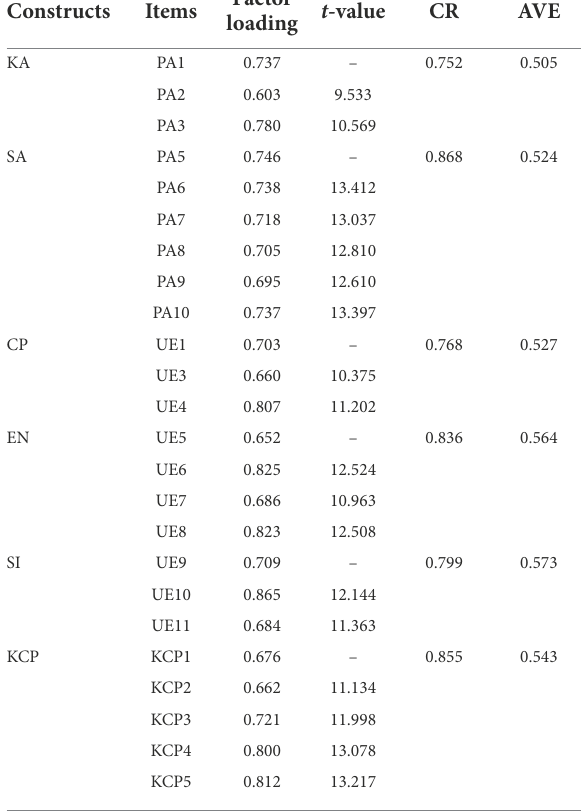
TABLE 6 Convergent